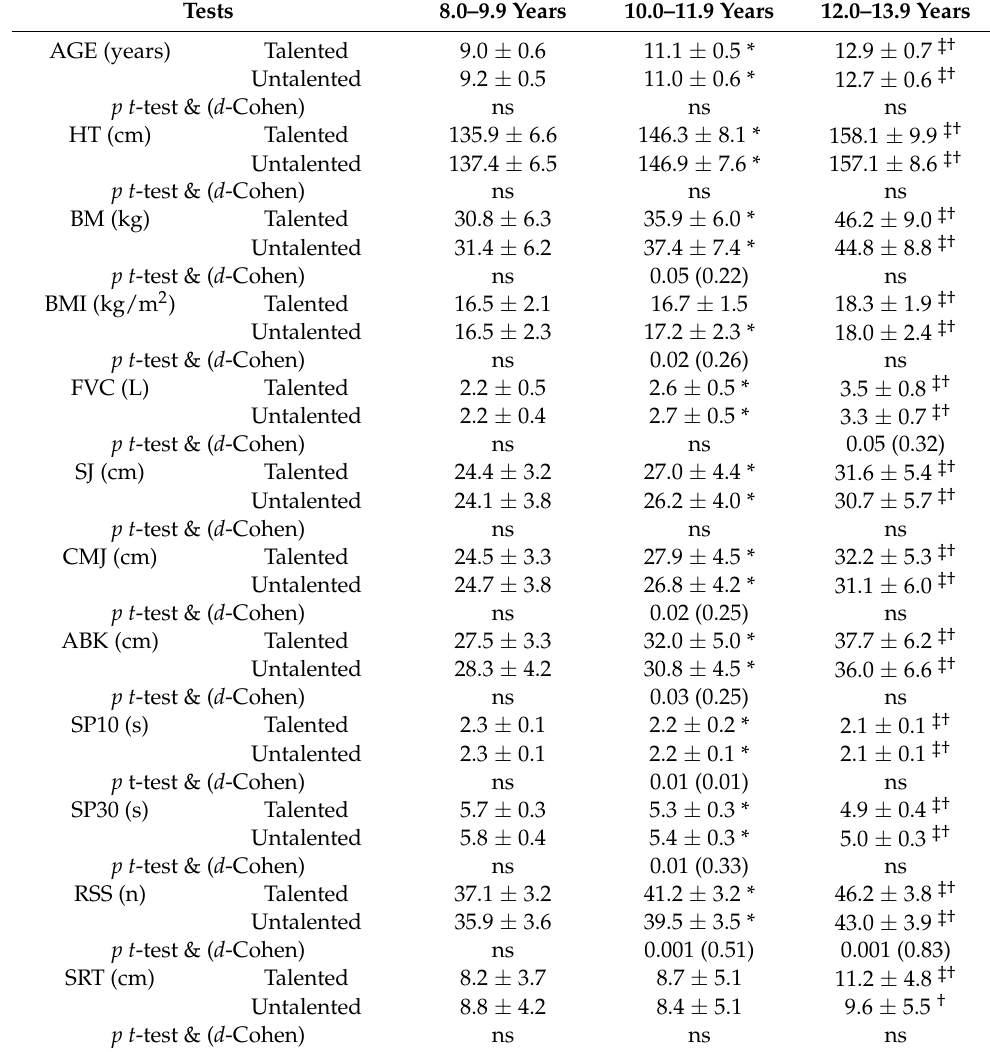
Table 3. Comparative analysis applied to 722 Chinese children soccer players: One-way ANOVA between age groups (results are showed in rows) and Student’s t tests (talented vs. untalented), with the effect size showed in columns for significant